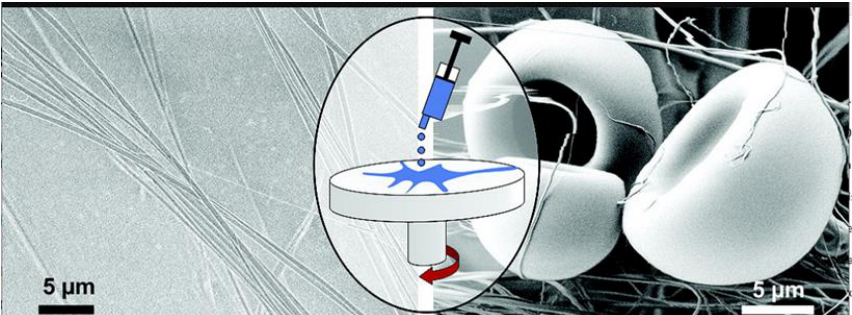
Figure 15. Spinning process and SEM images of the polymethylmethacrylate nanofibre. Reproduced with permission from [137], copyright 2008 American Chemical Society.